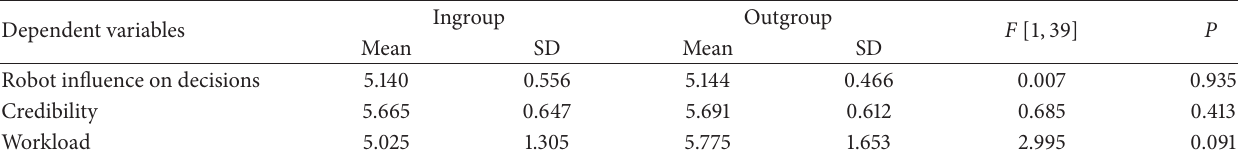
Table 6: Univariate effects for group